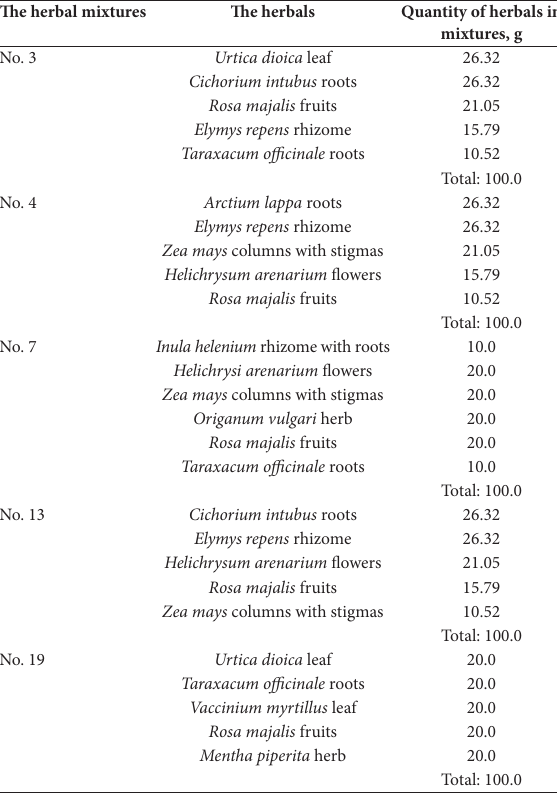
Table 1. Composition of herbal mixtures. The herbal mixtures The herbals Quantity of herbals in